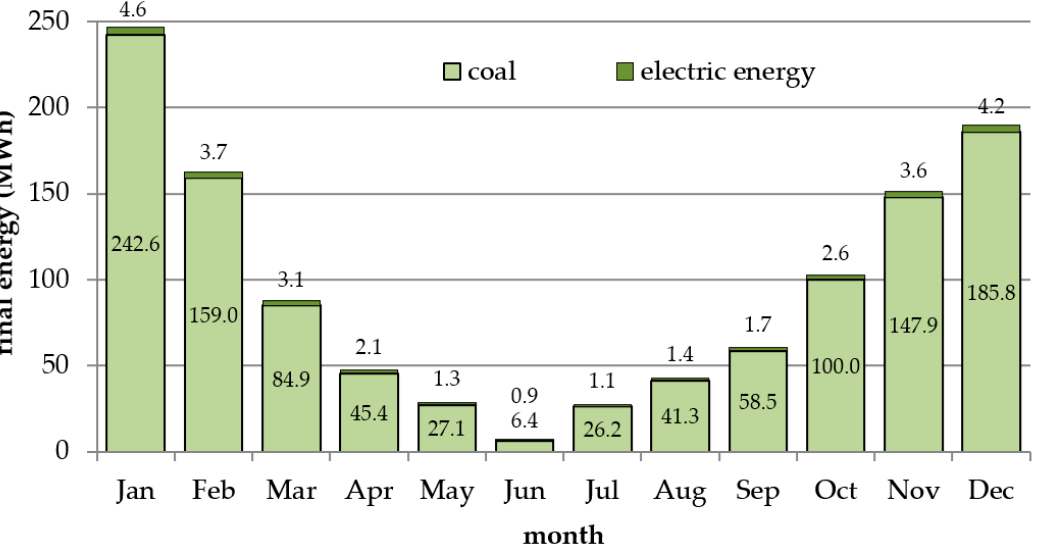
Figure 2. Monthly totals of final energy used for heating and auxiliary electricity used for the GH; fuel — coal (scenario 1).